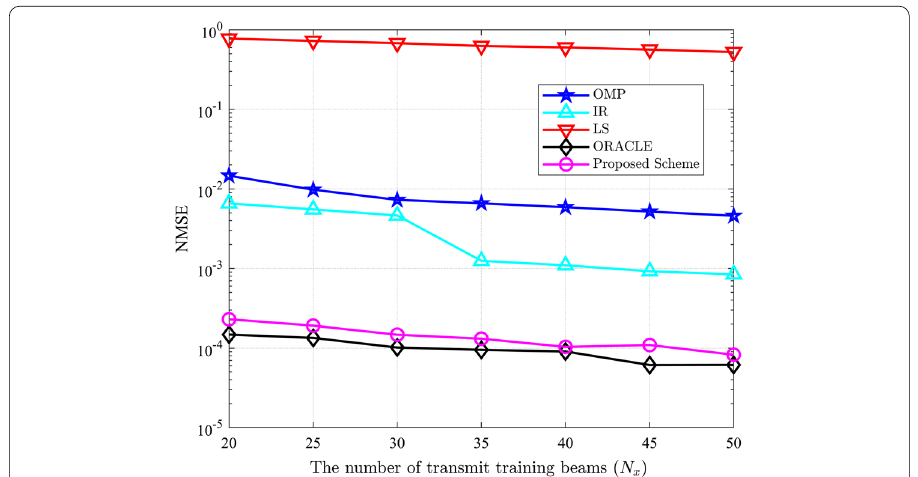
Fig. 6 NMSE performance against the number of training beams when N y = 32 , N t = N r = 64 are considered,